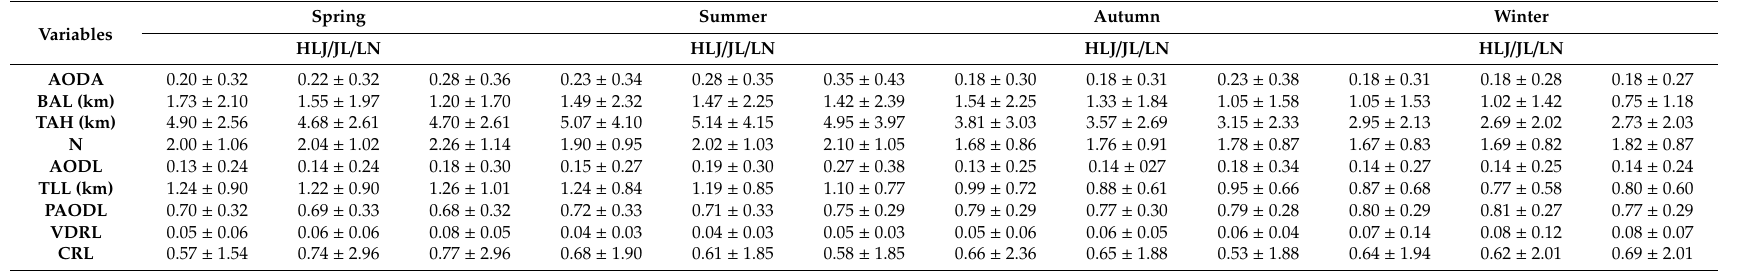
Table 2. Seasonal mean and standard deviation values of nine variables in the nighttime over NEC (HLJ, JL, and LN).